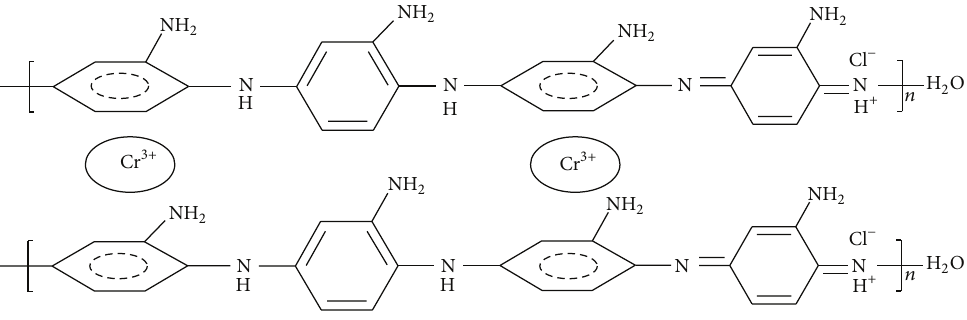
Scheme 1: Structure of the prepared (POPDA). Table 3: Infrared absorption bands and their assignments of o- phenylene-diamine monomer (OPDA) and its analogs polymer